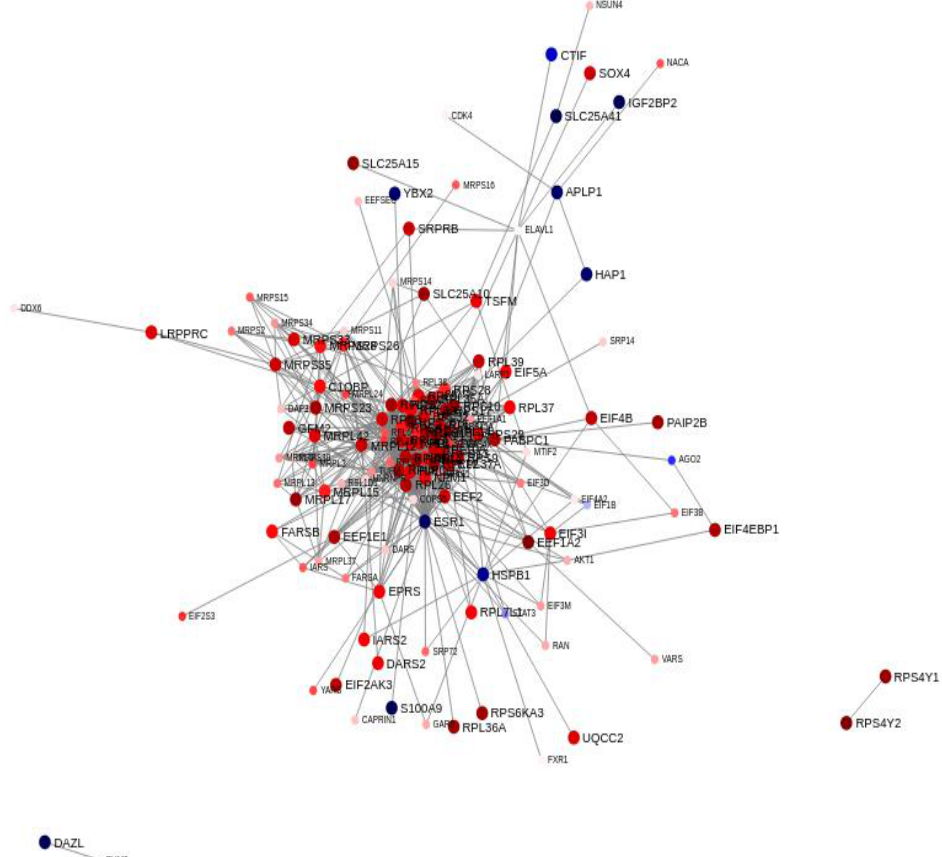
Figure 8. Interaction network of 187 signature genes using The Search Tool for Retrieval of Interacting Genes/Proteins (STRING) Protein-protein interaction (PPI) database. A node represents an individual protein and the edge connecting two nodes represents the relationship between them, i.e., they represent interacting proteins. Nodes with significantly higher degree than other nodes within a system are hub nodes. The nodal color reflects direction and size of regulation in AA men compared to EA men as defined by fold-change values from the experiment. Nodes with no interactions are excluded from the visualization.